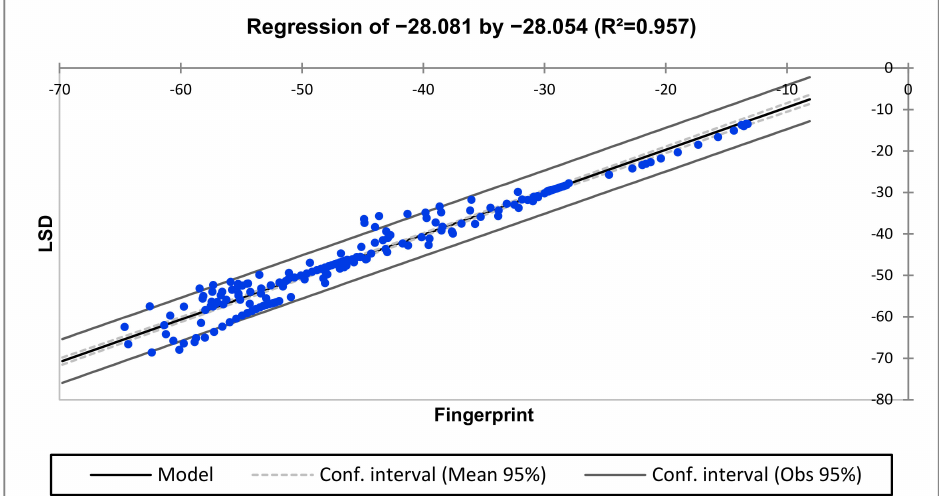
Figure 25. Regression for H3-H2 vs. H1-H3 (medium-frequency